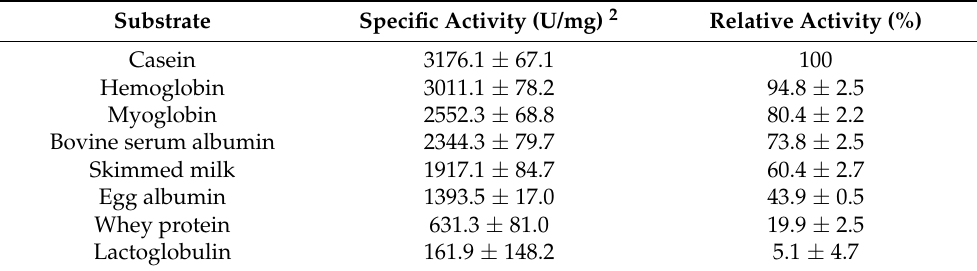
Table 1. Substrate Specific Activities of RmproB 1